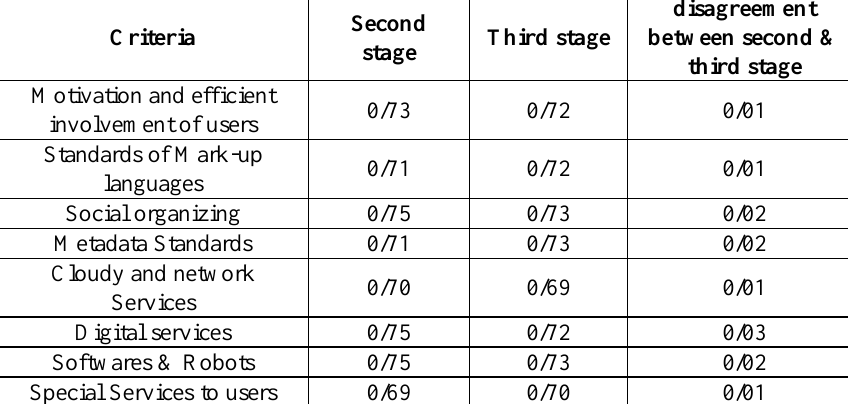
Table 9. The rate of disagreement between expert's view points at the second and third stage of the poll disagreement Second Criteria Third stage between second & stage third stage Motivation and efficient 0/73 0/72 0/01 involvement of users Standards of Mark-up 0/71 0/72 0/01 languages Social organizing 0/75